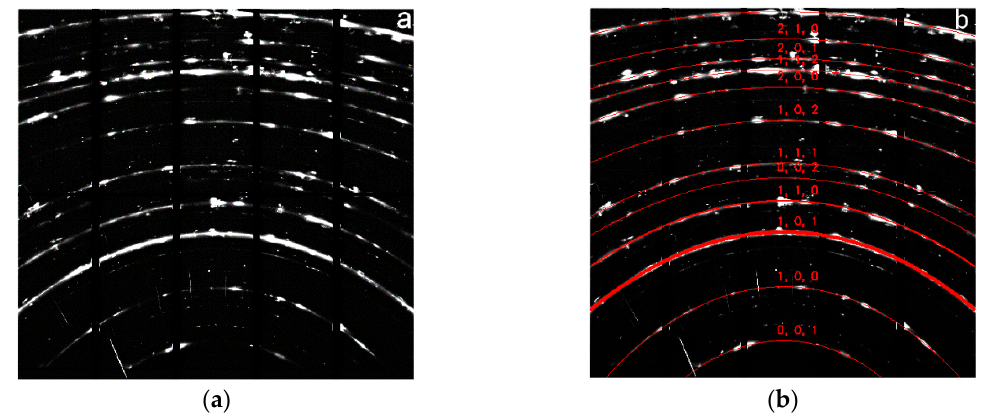
Figure 4. The observed and indexed powder-diffraction patterns ( a and b , respectively) of a specimen of platiniferous tetra-auricupride at Bolshoy Khailyk, which were obtained by summing scans over a large area of the matrix phase in the detrital grain shown in Figure 2.